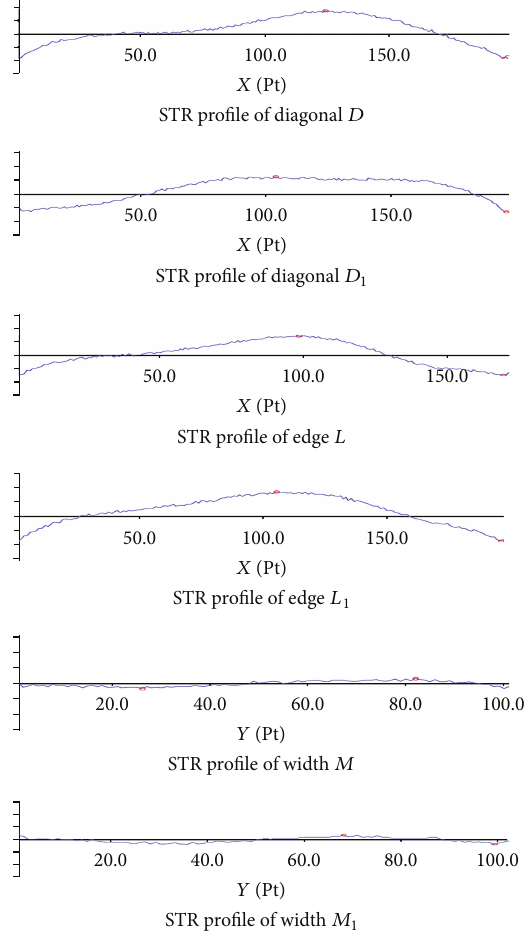
Figure 5: Result of STR form for 𝐷 and 𝐷 1 , 𝐿 and 𝐿 1 , 𝑀 and 𝑀 1 lines for third specimen using new